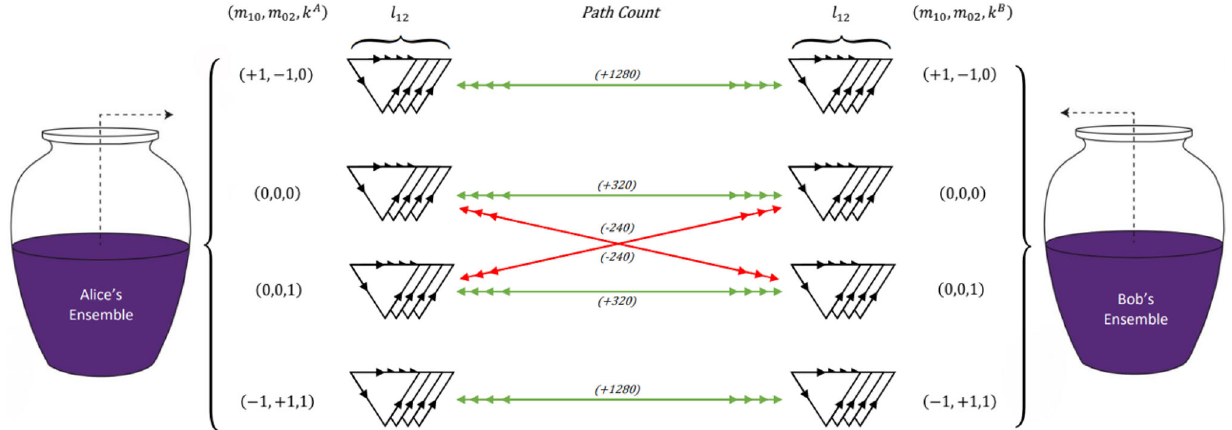
bers. The probability of obtaining a particular combination of m 10 and m 02 can be found by dividing the number of paths associated with that combination by the total sum of paths for all